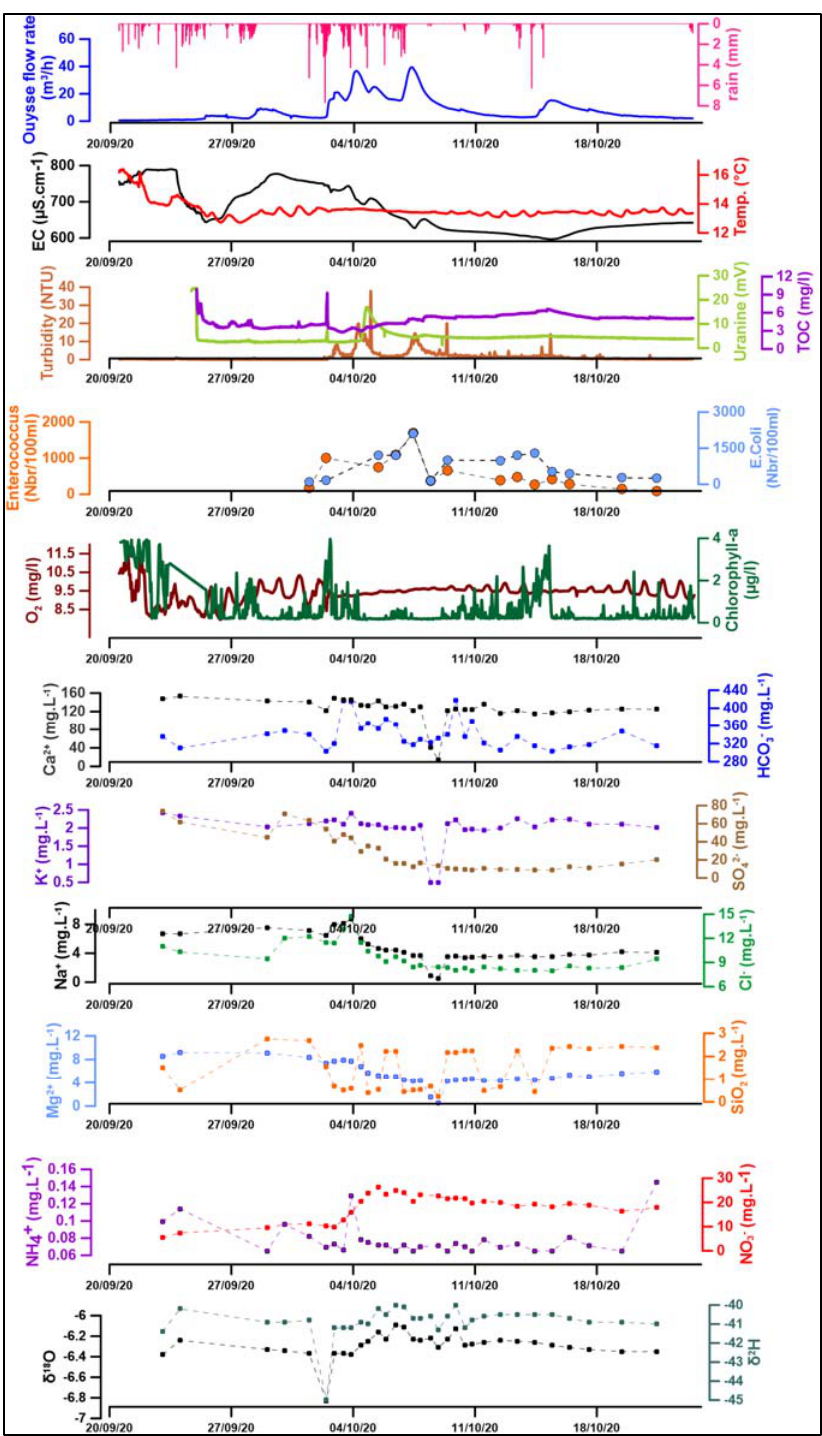
Figure B4. Chemiograph of the Cabouy spring from 20/09/20 to 21/10/20. Figure A7. Chemiograph of the Cabouy spring from 20/09/20 to